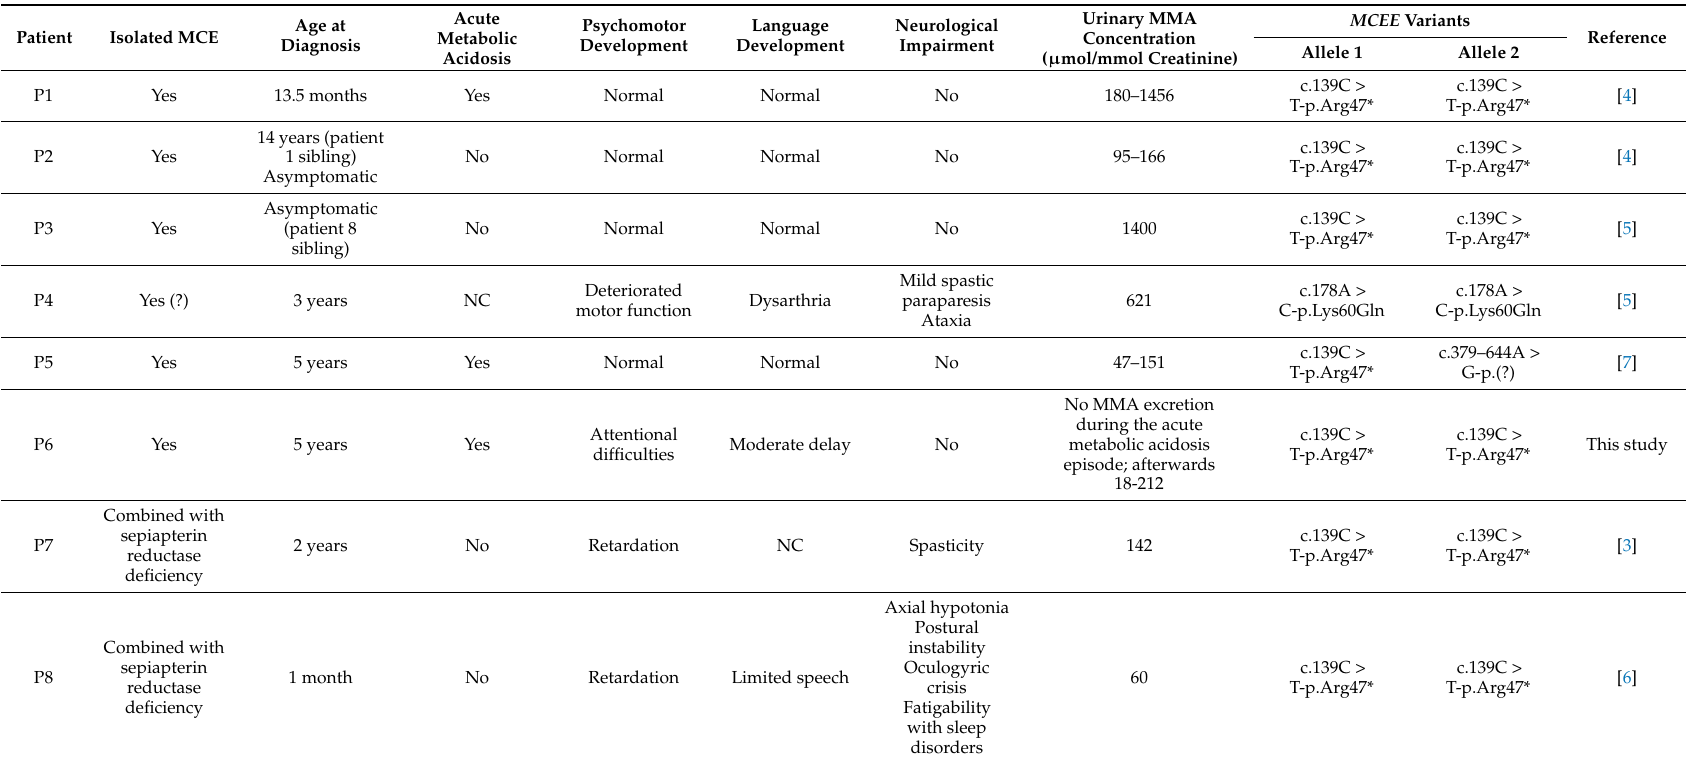
Table 1. Clinical, biochemical, and molecular characteristics of the described MCE